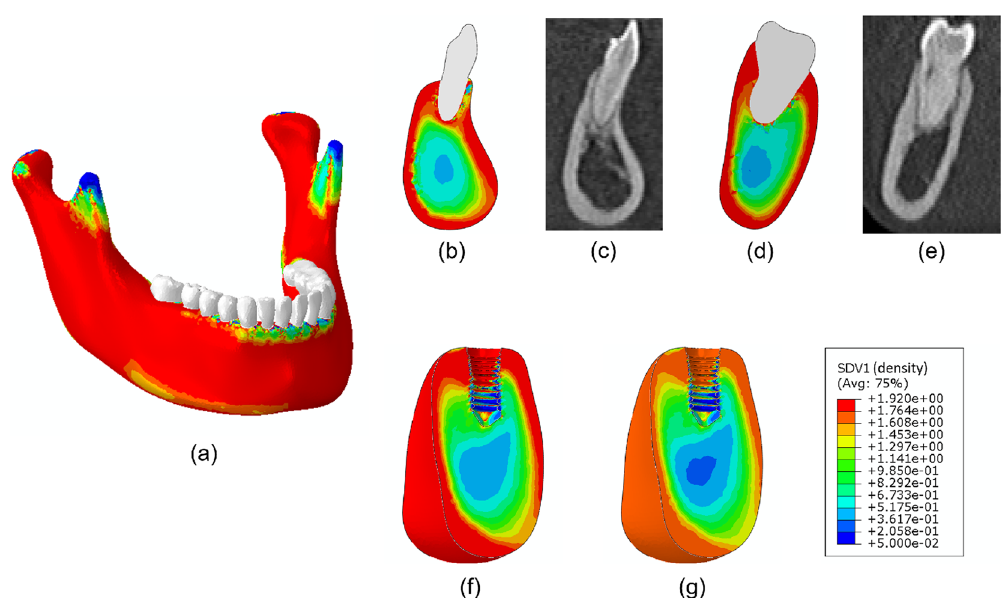
Figure 6. Bone density distribution ( g / cm 3 ) in the mandible and several cross-sections. ( a ) Mandible, ( b ) cross section containing the incisor, ( c ) CT image of the corresponding incisor cross section, ( d ) cross section of second right molar, ( e ) CT image of the corresponding second right molar section, ( f ) lingual-labial cut view of the isolated model and ( g ) density of the osteoporotic state in the same cut